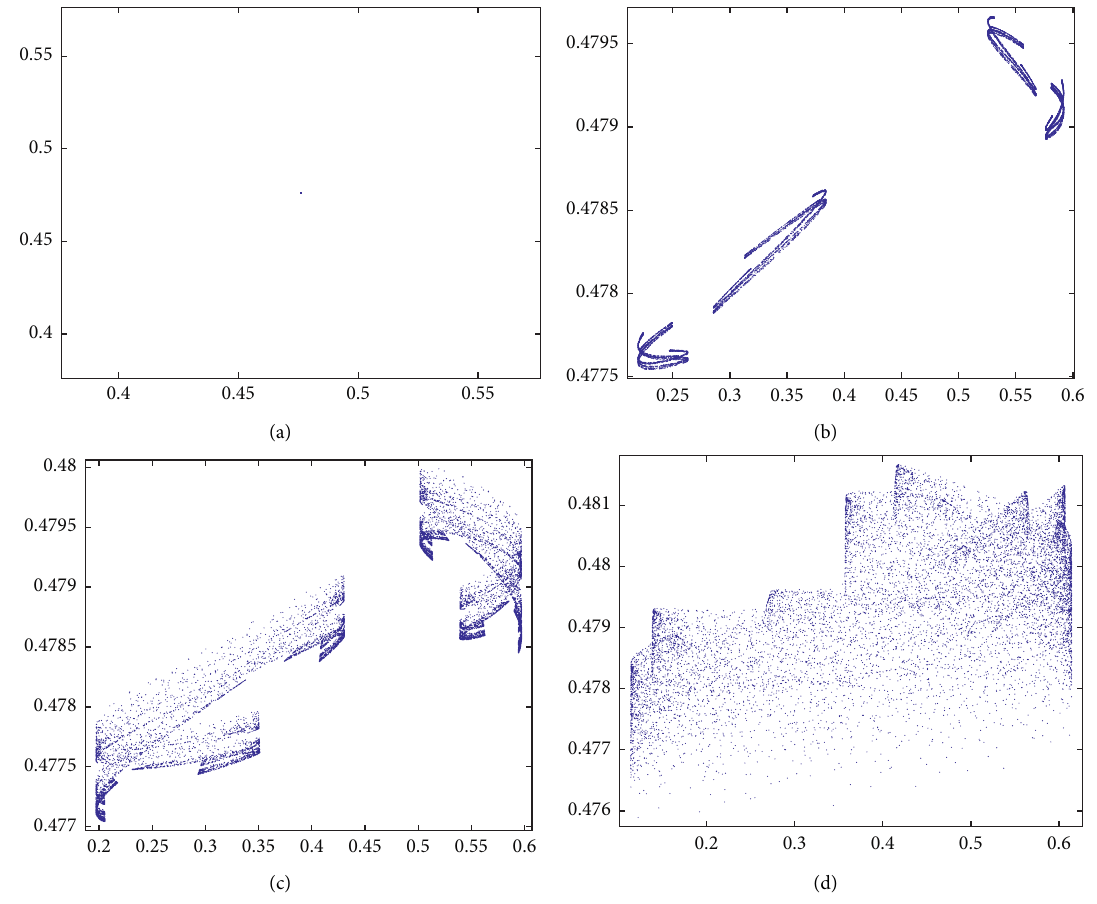
Figure 5: The stable region of both bargaining